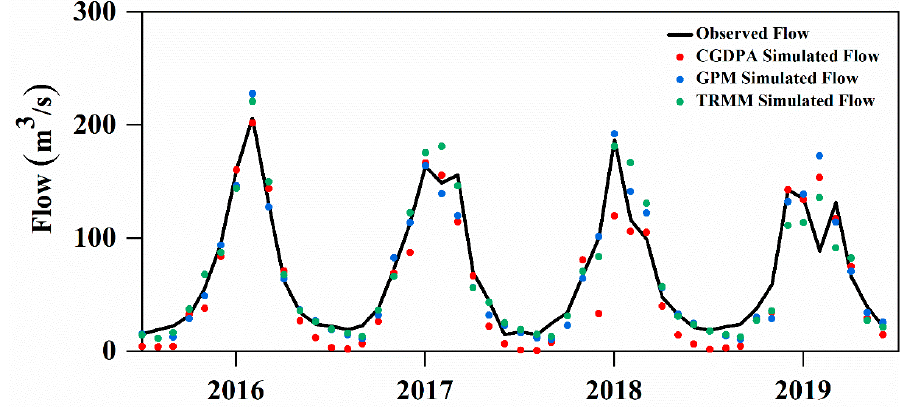
Figure 3. Plot of the simulated runoff via the TVGM-DDF with the fixed parameter. Table 5. Precision of different SPPs driven hydrological models under different scenarios.